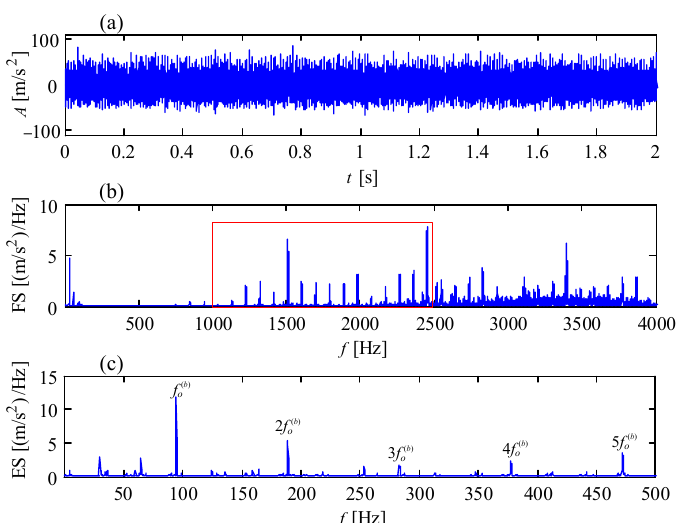
Figure 15. Vibration signal of faulty generator bearing at drive end: ( a ) temporal signal; ( b ) Fourier spectrum; ( c ) envelope spectrum.